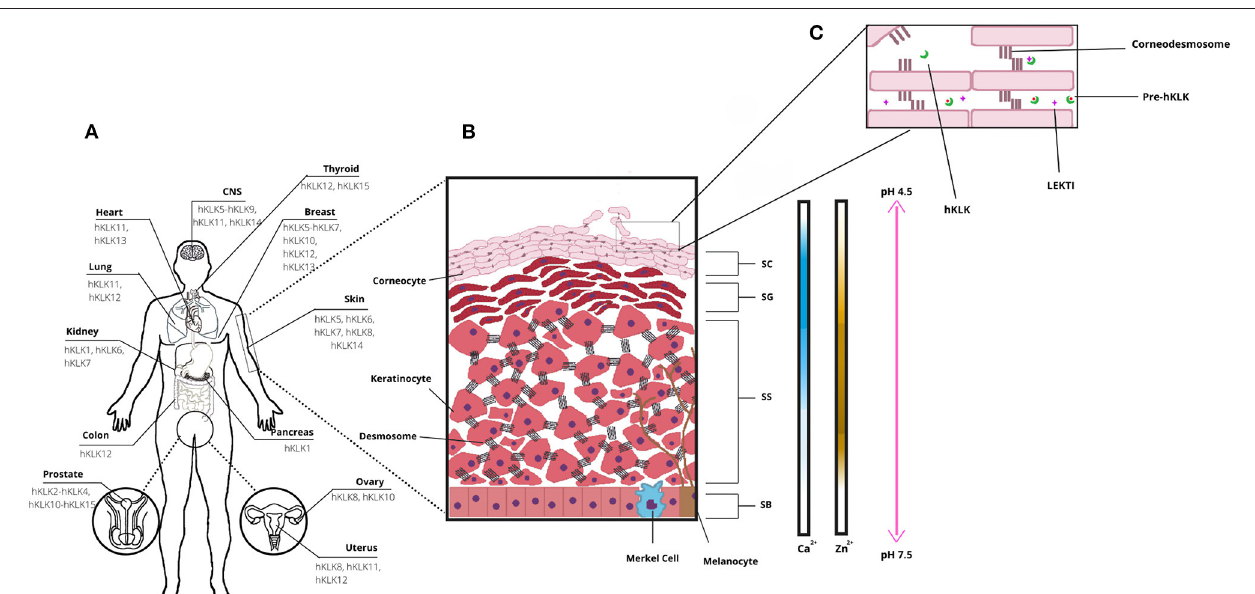
FIGURE 1 | Human tissue Kallikrein-related peptidases (hKLKs) distribution and their functional role in the skin. (A) Distribution of the main KLKs in human tissues. (B) Structure of skin epidermis, the main layers, and Ca 2 + , Zn 2 + , and pH distribution, from Stratum Basale to Stratum Corneum. (C) Stratum Corneum (SC) and skin desquamation, a physiological process with the involvement of hKLKs, targeting the Corneodesmossome, structure responsible to maintain Corneocytes adhesion. hKLKs are expressed as a pre-enzyme not functional in deeper layers of the epidermis. Upon reaching the SC, hKLKs are activated and regulated by the natural inhibitor LEKTI. Skin desquamation is a finely regulated process in healthy subjects.